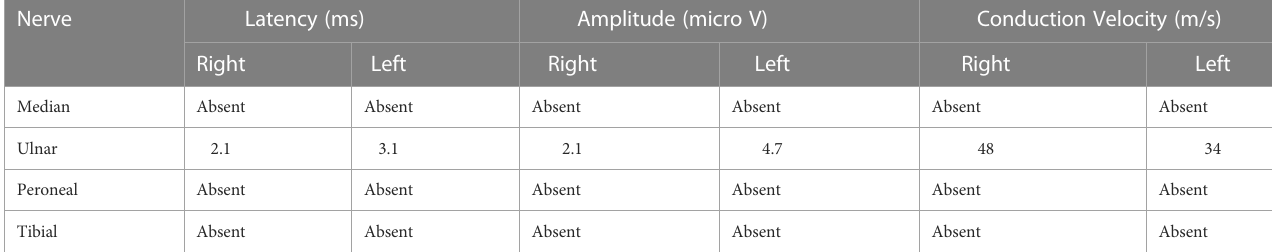
TABLE 3 Sensory nerve conduction study.